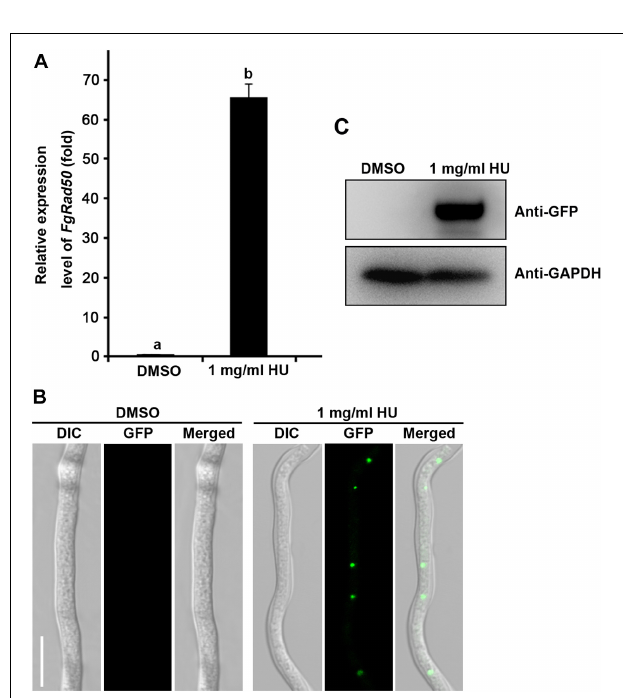
FIGURE 6 | Expression pattern of FgRad50 in response to hydroxyurea (HU) induction. (A) The relative transcription level of FgRad50 in WT PH-1 treated with 1 mg/mL HU is the relative amount of mRNA transcript of the gene in PH-1 without HU treatment (i.e., the solvent DMSO control). (B) Subcellular localization of the FgRad50-GFP transformant ( (cid:49) FgRad50-C) after HU induction. The FgRad50-GFP strain was inoculated in potato dextrose broth (PDB) and cultured at 25 ◦ C for 36 h with shaking, then treated with or without 1 mg/mL HU for 30 min, and imaged. DIC, differential interference contrast. Bar = 10 µ m. (C) FgRad50 protein content was dramatically increased after 1 mg/mL HU treatment for 30 min determined by Western blotting with monoclonal anti-GFP antibody. The protein samples were also detected with monoclonal anti-GAPDH antibody as a